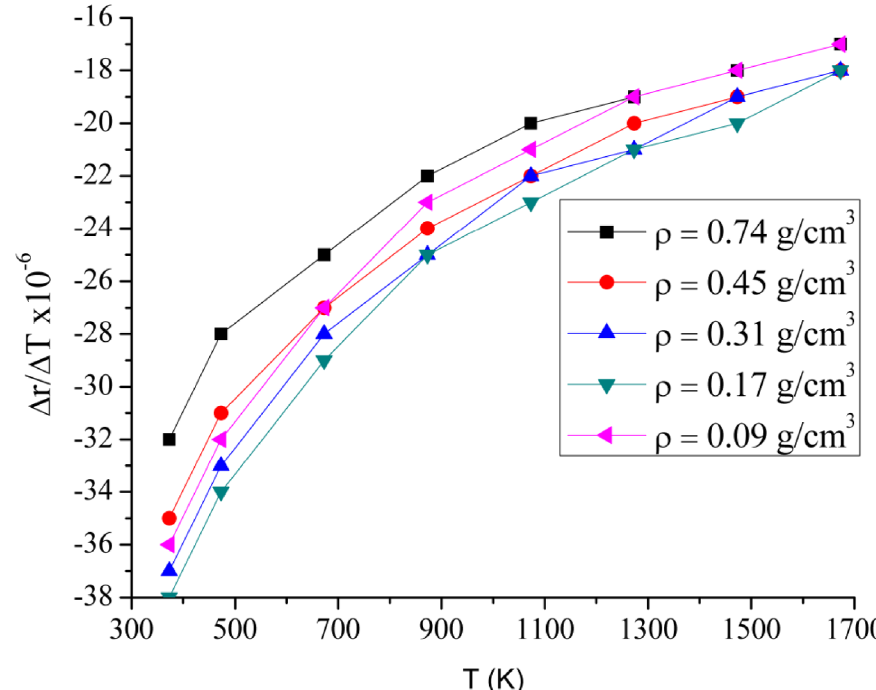
Fig. 5. Reactivity coef fi cients obtained with HELIOS-2 for 177 energy groups at different densities.